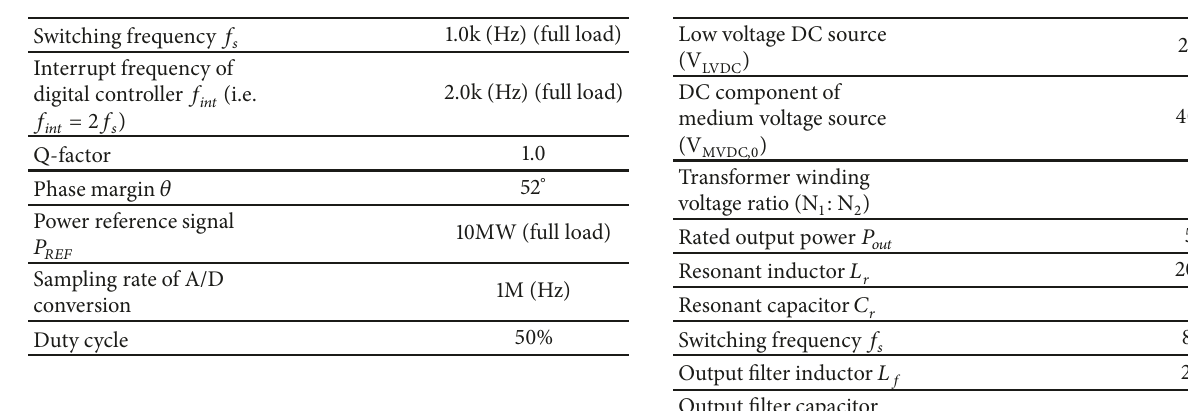
Table 2: Specifications of digital controller. Table 3: Specifications of laboratory test